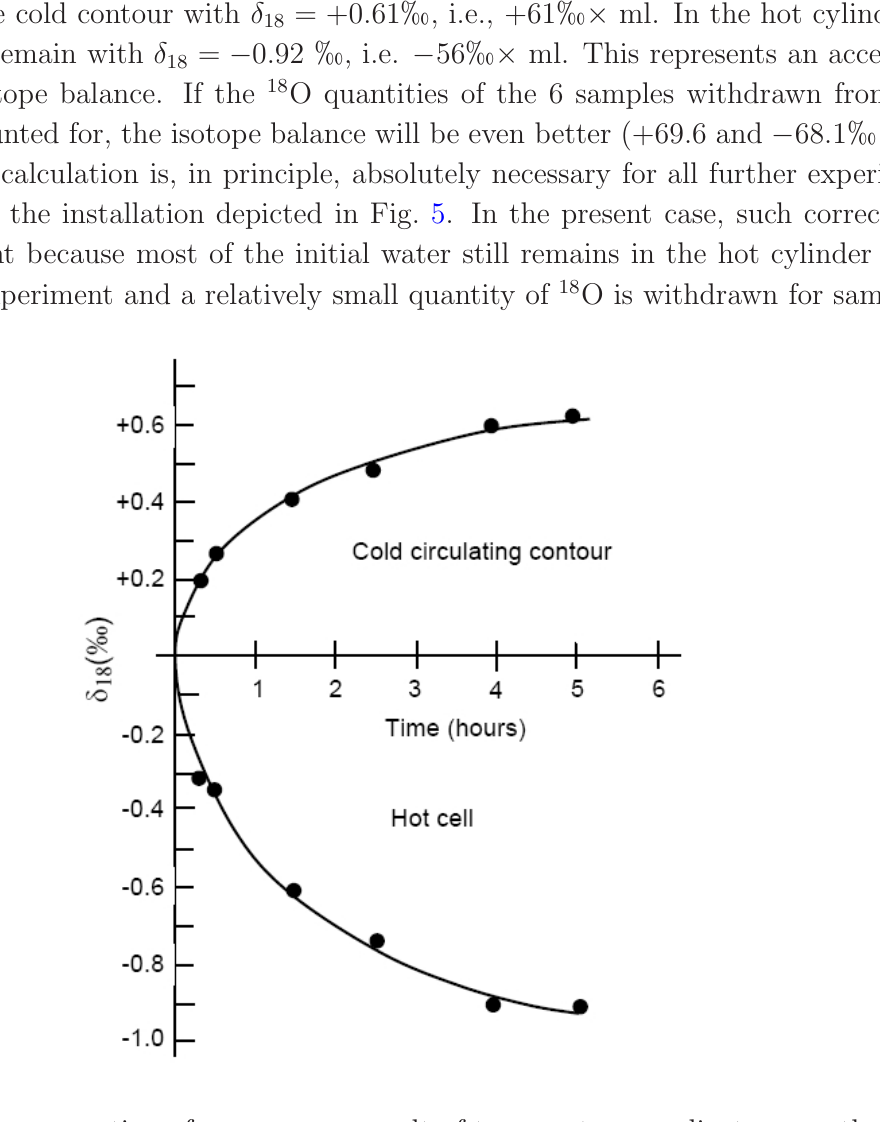
Fig. 7 Isotope separation of oxygen as a result of temperature gradient across the mem- brane. δ change in both cells over time. Conditions: membrane - 75 μ , the temperature 18 in the hot and cold cells are 90 and 40 ◦ C,